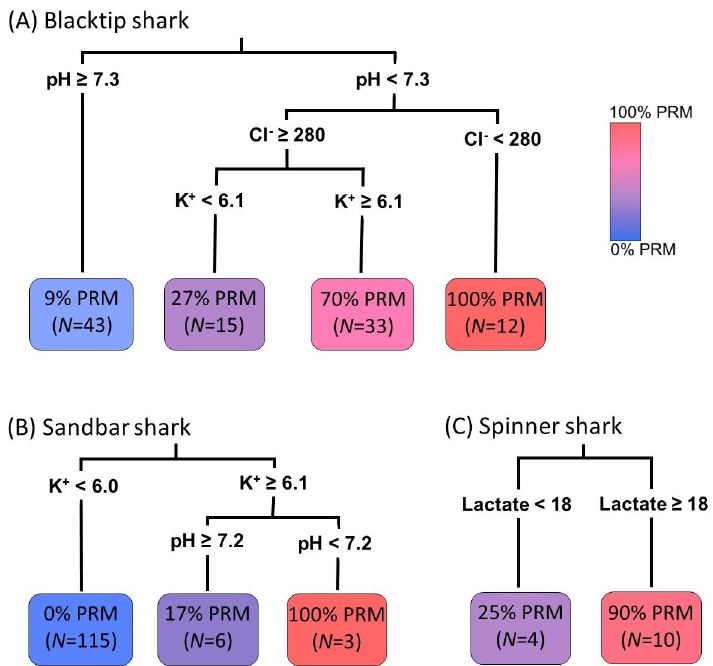
Fig 5. Decision trees using at-vessel metrics to predict post-release outcomes for (A) blacktip, (B) sandbar, and (C) spinner sharks.